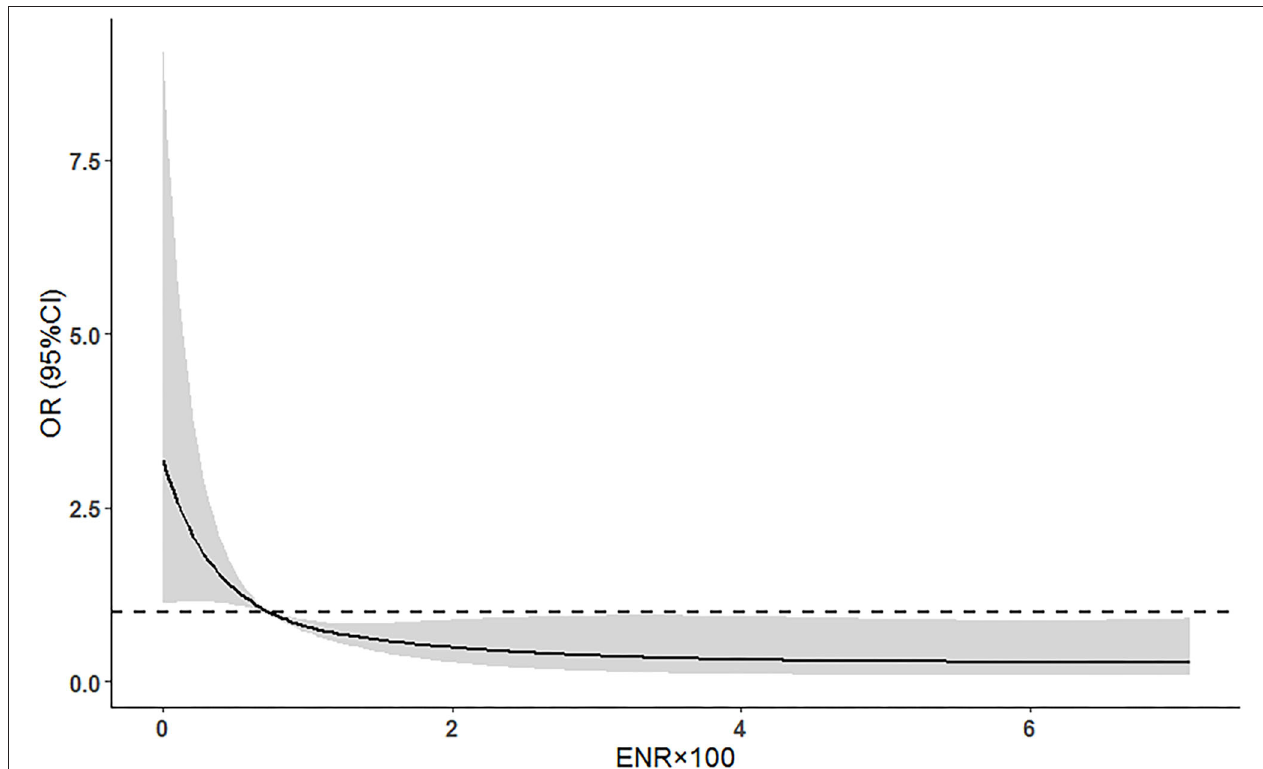
FIGURE 4 | Adjusted association of ENR with 3-month poor outcomes using multiple spline regression analyses with four knots (at the 5th, 35th, 65th, and 95th percentiles). The solid line indicates odds ratio while the shadow indicates 95% CIs. The dashed line is the reference line (odds ratio = 1). The reference of ENR was 0.74. Data were adjusted for age, current smoking, hypertension, atrial fibrillation, prior stroke, baseline NIHSS score, and stroke subtype. ENR, eosinophil-to-neutrophil ratio; NIHSS, National Institute of Health Stroke